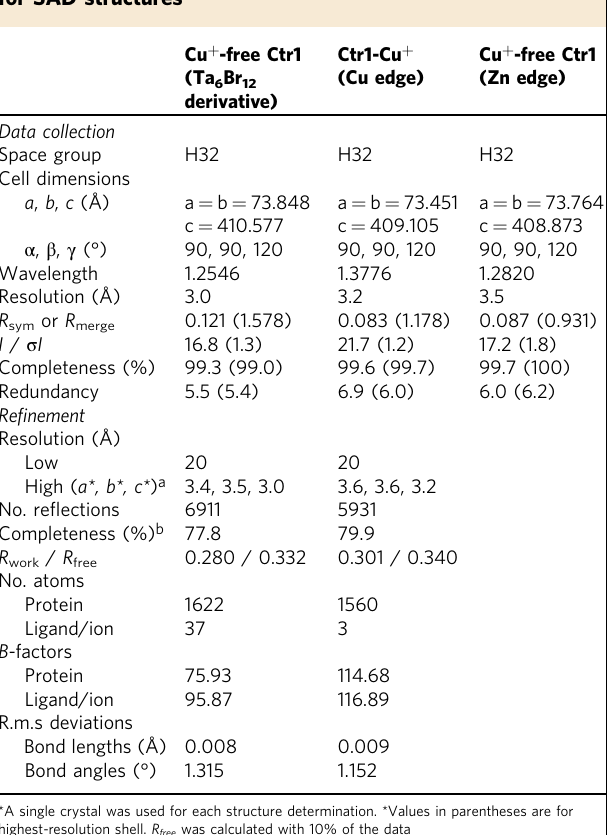
Table 1 Data collection, phasing, and re fi nement statistics for SAD